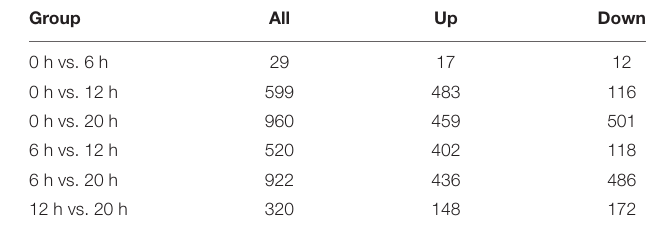
TABLE 3 | Differentially expressed